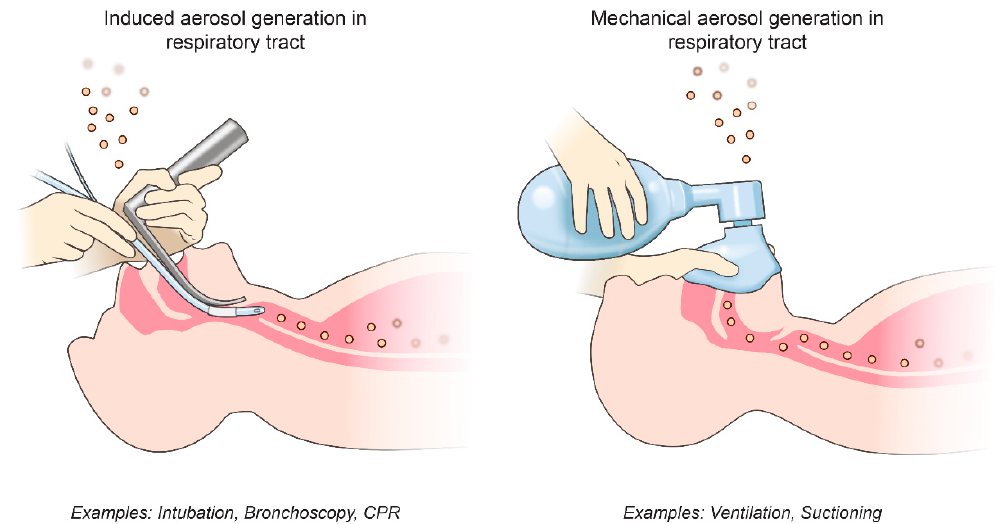
Figure 1. Potential types of aerosol-generating medical procedures (AGMPs). AGMPs can be divided into procedures that induce the patient to produce aerosols and procedures that mechanically generate aerosols themselves. Table 1. Potential aerosol-generating medical procedures involved in nosocomial virus transmission. AGMP How/Where Aerosols may Be Generated